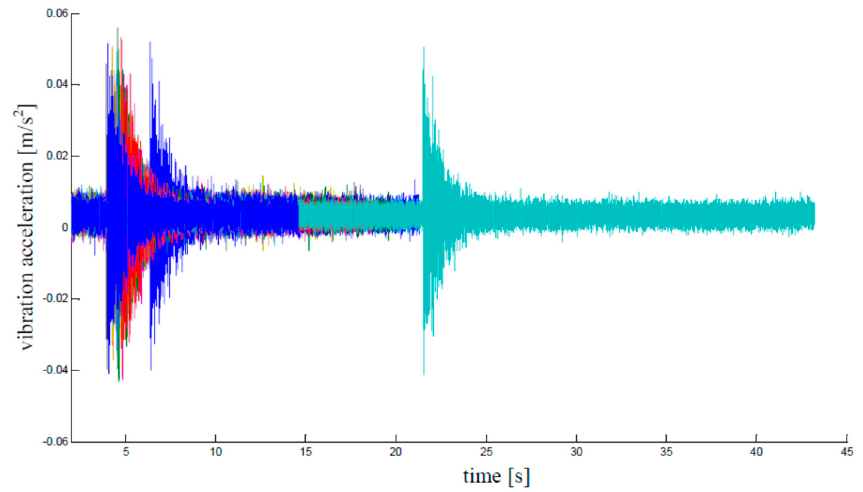
Figure 6. Time dependencies between system responses measured at the reference point in all the 11 partial